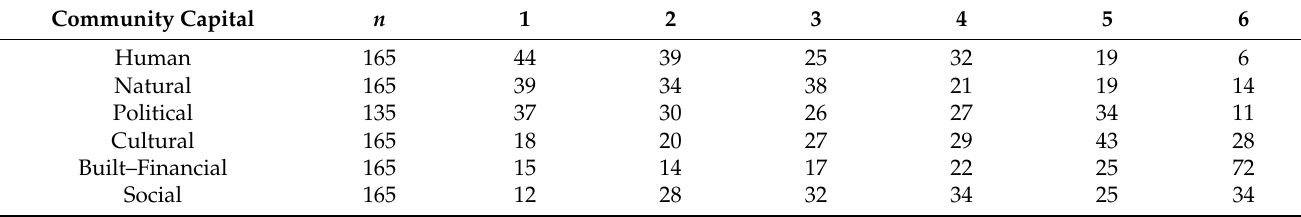
Table 2. Absolute Ranking Frequency Counts for Single Items.